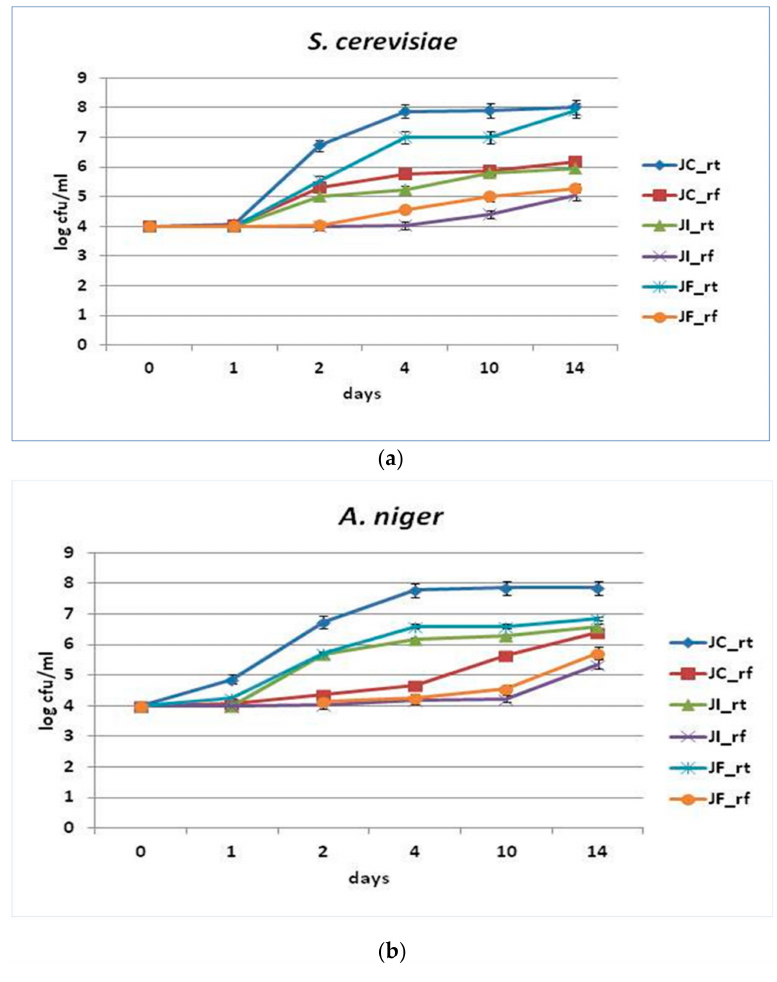
Figure 2. Effect of free or immobilized L. rhamnosus OLXAL-1 on apple pieces in novel functional juices deliberately spiked with ( a ) S. cerevisiae , or ( b ) A. niger , after 2 weeks of storage at 20 ◦ C (rt) or 4 ◦ C (rf). JC: control; JI: Juice with immobilized cells; JF: Juice with free